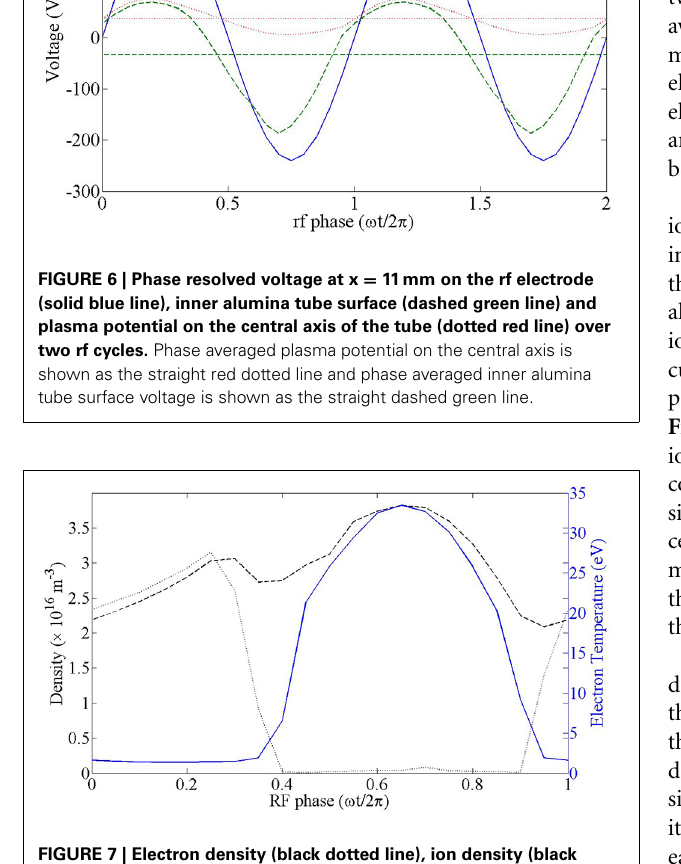
FIGURE 7 | Electron density (black dotted line), ion density (black dashed line) and electron temperature (blue solid line) with rf phase at a point in the discharge in line with the rf electrode (x = 11mm) and 0.1 mm from the inner surface of the dielectric tube (y =